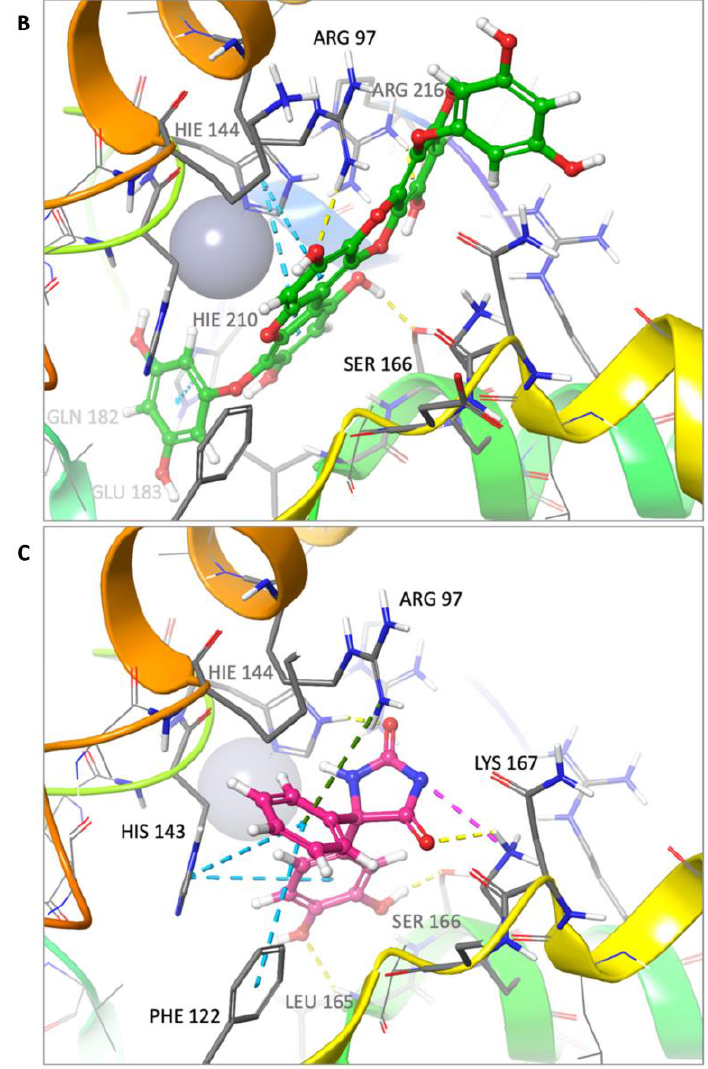
Figure 8. ( A ) Olsalazine, ( B ) phlorofucofuroeckol and ( C ) phenytoin catechol, docked in the GTPCH1-binding pocket. All bonds are depicted as dotted lines: hydrogen bonds—yellow; salt bridges—pink; aromatic H-bond—cyan; pi–pi stacking—blue; pi-cation—green. Binding residues are annotated, and the zinc ion is depicted as a grey